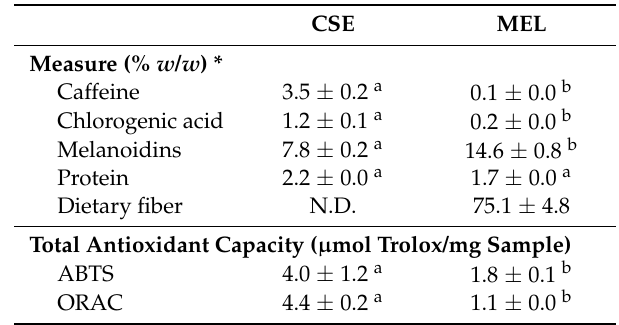
Table 2. Chemical composition and in vitro bioactivity of coffee silverskin extract (CSE) and melanoidins